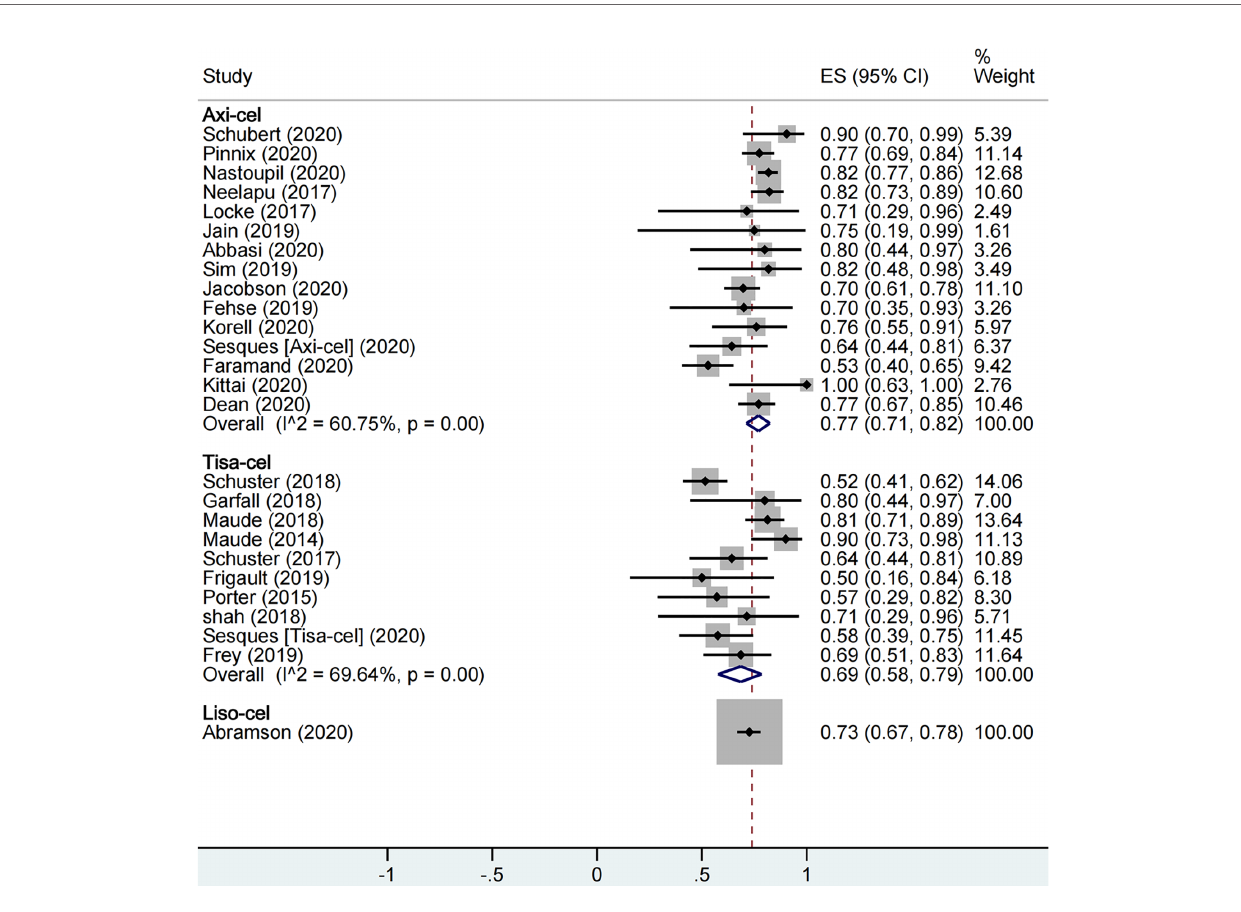
FIGURE 2 | The forest plot of total overall response rate of each